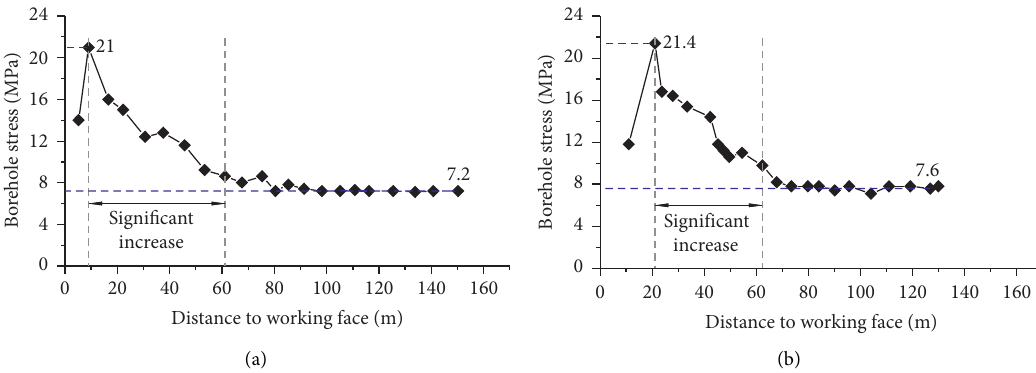
Figure 15: Lead abutment pressure monitoring results. (a) 1# Borehole. (b) 2#